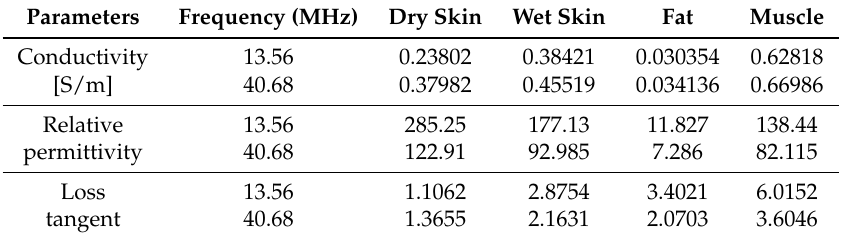
Table 3. The dielectric properties of the human body tissue at 13.56 MHz and 40.68 MHz [30].